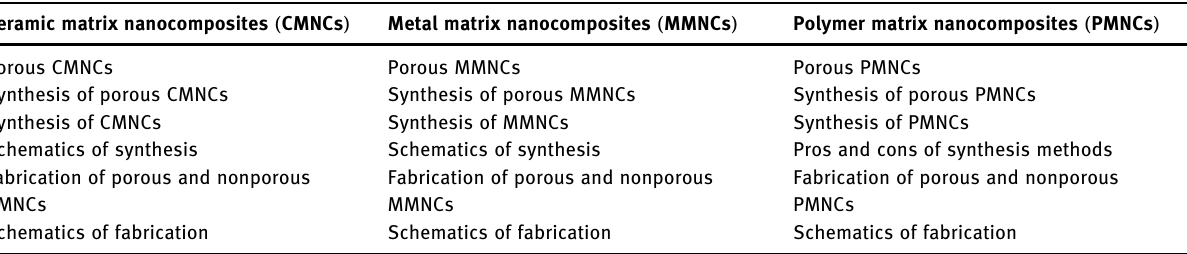
Table 1: Main nanocomposites ’ categories. Subcategories are given under each nanocomposite and represent the order of study, which is further